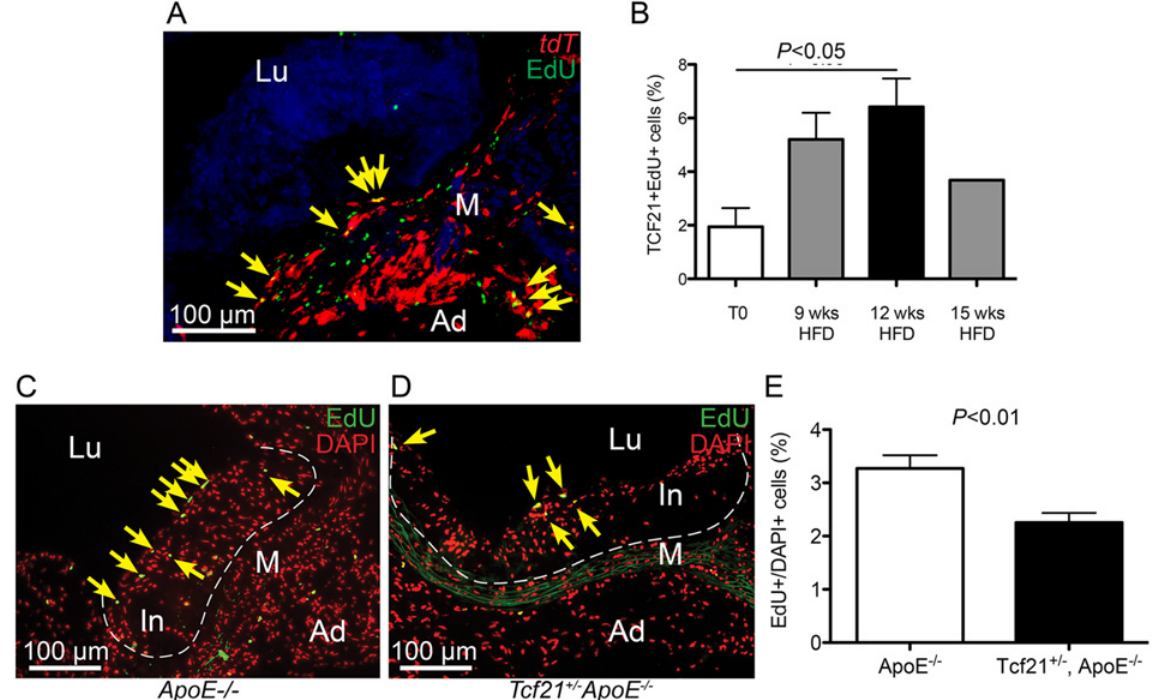
Fig 7. Rate of cell division in vascular lesions is related to Tcf21 expression. A) EdU staining was performed in Tcf21 iCre/+ , ROSA tdT/+ , Ldlr -/- mice treated with tamoxifen and EdU and placed on HFD for 9, 12, or 15 weeks prior to tissue collection. Co-localization of Tcf21 tdT fluorescence (red) and EdU fluorescent staining (green) allowed identification of the sdividing cells that were expressing Tcf21 (yellow arrows, image from 12 week timepoint). B) The ratio of Tcf21 +EdU+ cells compared to total Tcf21 + cells was significantly increased at 12 weeks of diet, consistent with a proliferative response in Tcf21 + cells. Comparison of percentage differences between 0 and 9 weeks, and from 9 to 12 weeks approached significance, P = 0.06; there was not a statistical difference between 12 and 15 weeks, P = 0.11. C, D) Rates of cell division in vascular lesions were compared between Tcf21 lacZ/+ , ApoE -/- animals and ApoE -/- animals on HFD for 20 wks by quantifying the relative number of dividing cells identified by EdU fluorescence compared to the total number of cells identified by DAPI fluorescence. EdU fluorescence (green) was merged with red pseudocolored DAPI fluorescence, yellow arrows indicate yellow nuclei that are positive for both EdU and DAPI fluorescence. E) A statistically significant decrease in this percentage in Tcf21 lacZ/+ , ApoE -/- animals compared to ApoE -/- animals suggested a correlation between Tcf21 expression and rate of cell division in the vascular lesions. In, intima; M, media; Ad, adventitia; FC, fibrous cap, Lu, lumen.